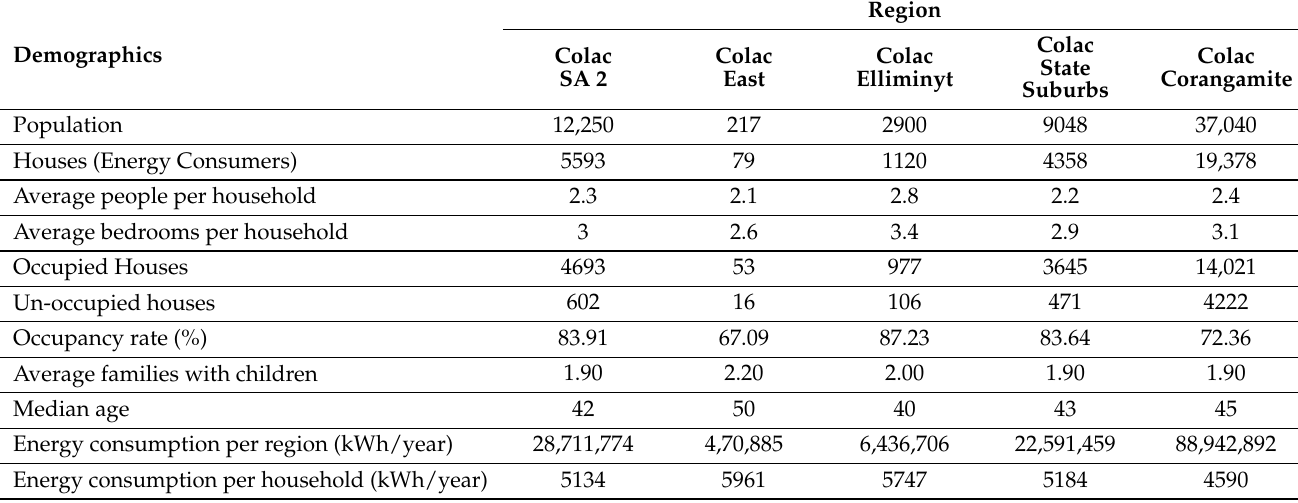
Table 4. Energy consumption calculations based on public demographic data.